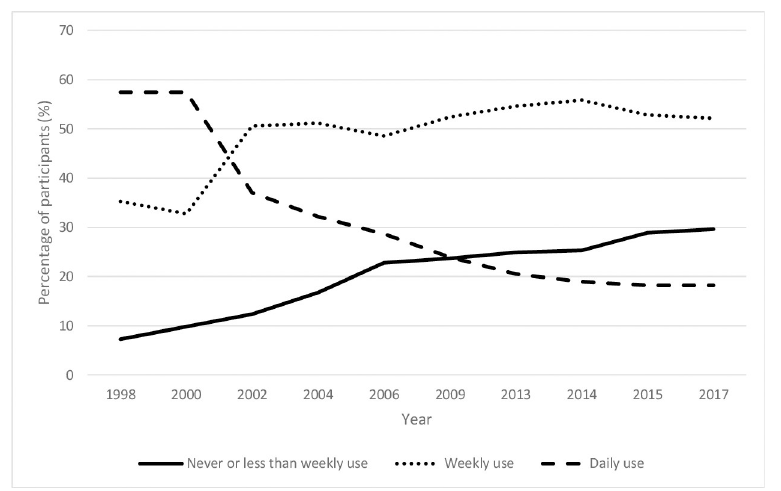
Fig 1. Reported SSB consumption between 1998 and